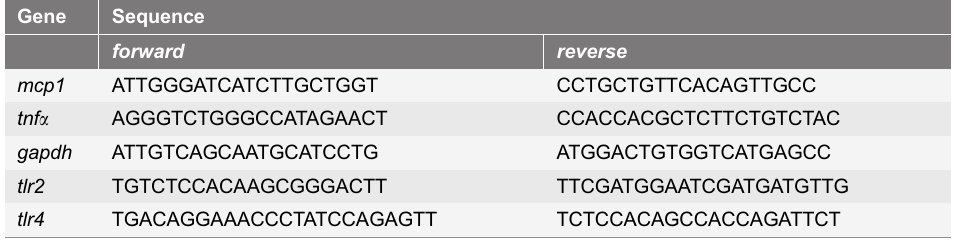
Table 1. Primer sequences used for quantitative real-time